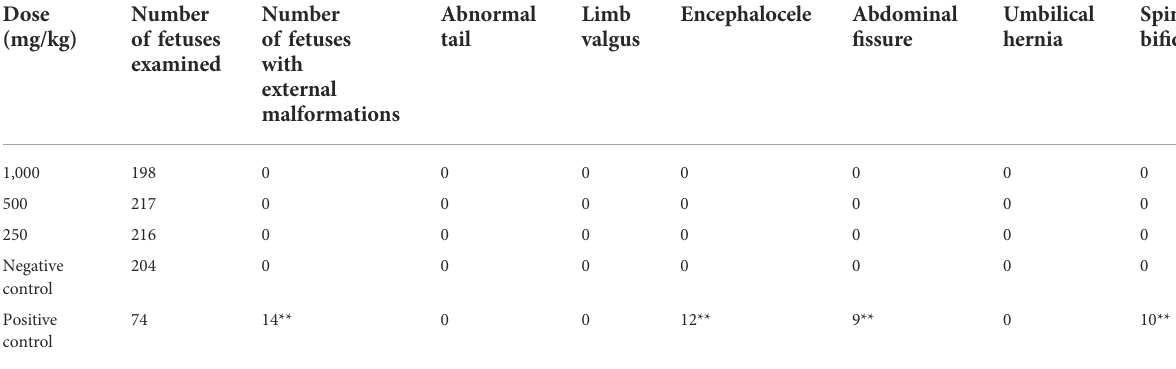
TABLE 3 Effects of water-extract sericin on external malformations of fetuses.